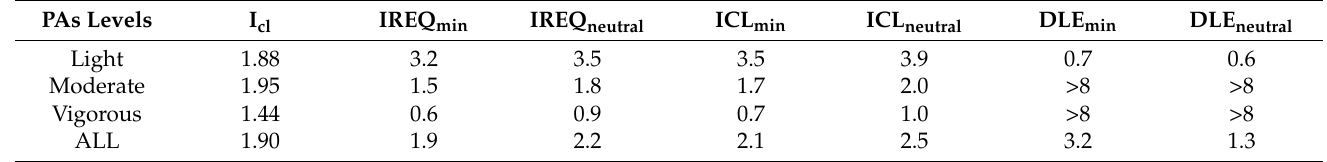
Table 7. IREQ, ICL, and DLE corresponding to light-, moderate-, and vigorous-intensity activities.